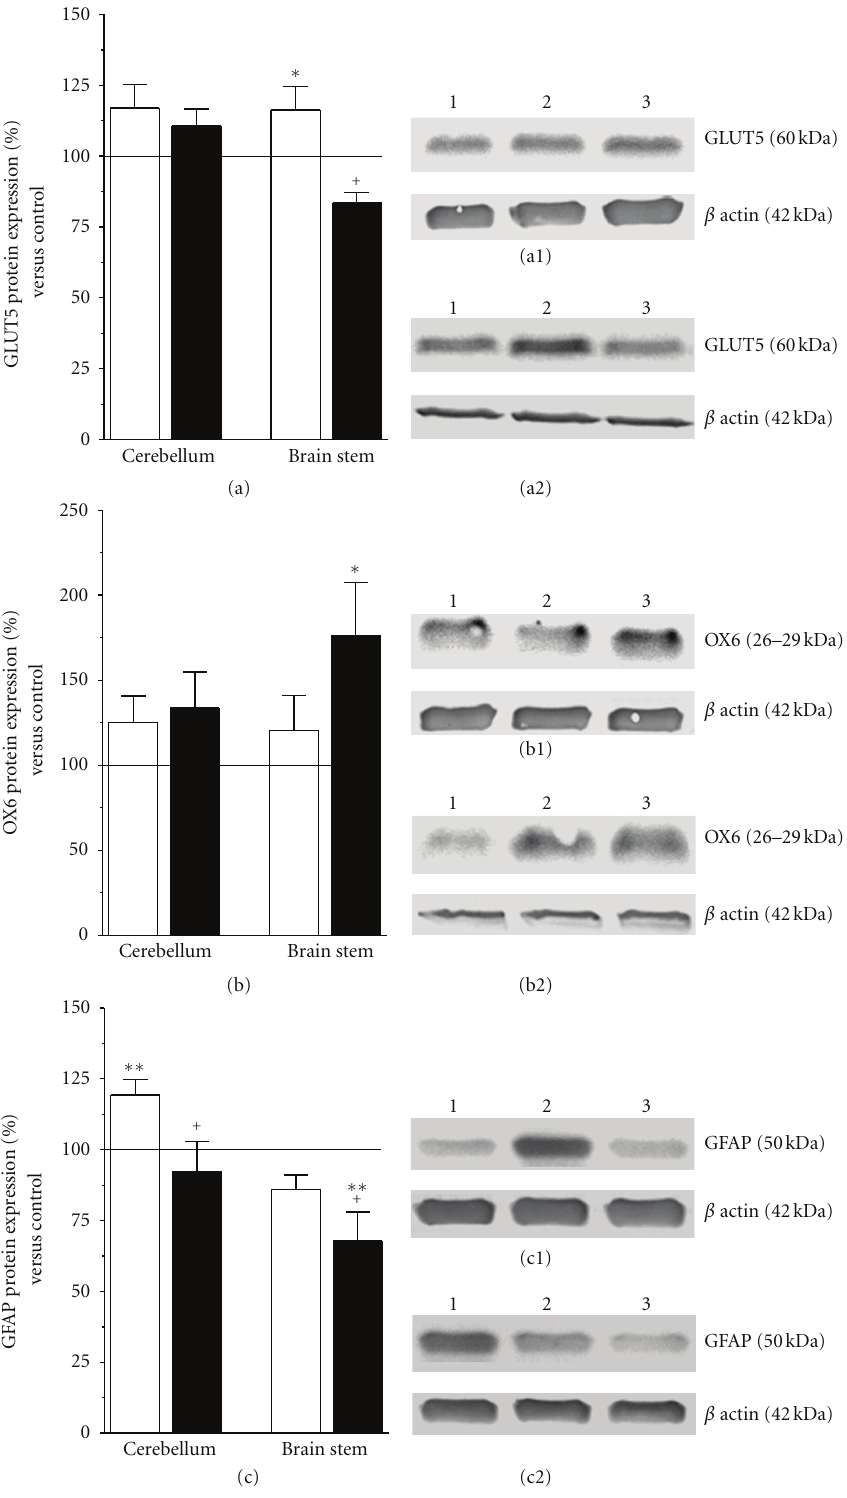
Figure 6: HuUCBMCs grafts modulate glial reactivity in 3-AP ataxic rats. (a), (b), and (c) show GLUT5 (a), OX6 (b), and GFAP (c) protein levels in the cerebellum and brain stem of 3-AP-lesioned rats receiving vehicle (3-AP + vehicle rats, white bars) or HuUCBMCs grafts (3-AP + cells rats, black bars). Note how HuUCBMCs transplantation upregulates OX6 protein expression in the brain stem and reduces GFAP protein levels in the cerebellum of 3-AP-lesioned rats. (a1) and (a2) show representative blots for GLUT5, (b1) and (b2) for OX6, and (c1) and (c2) for GFAP in the cerebellum (a1, b1, and c1) and brain stem (a2, b2, and c2). Lane 1: na¨ıve rats (control); lane 2: 3-AP + vehicle; lane 3: 3-AP + cells. Results represent the mean ± SEM of 9 to 15 individual animals. ∗ P ≤ 0 . 05, ∗∗ P ≤ 0 . 01 versus na¨ıve rats, + P ≤ 0 . 05 versus 3-AP + vehicle